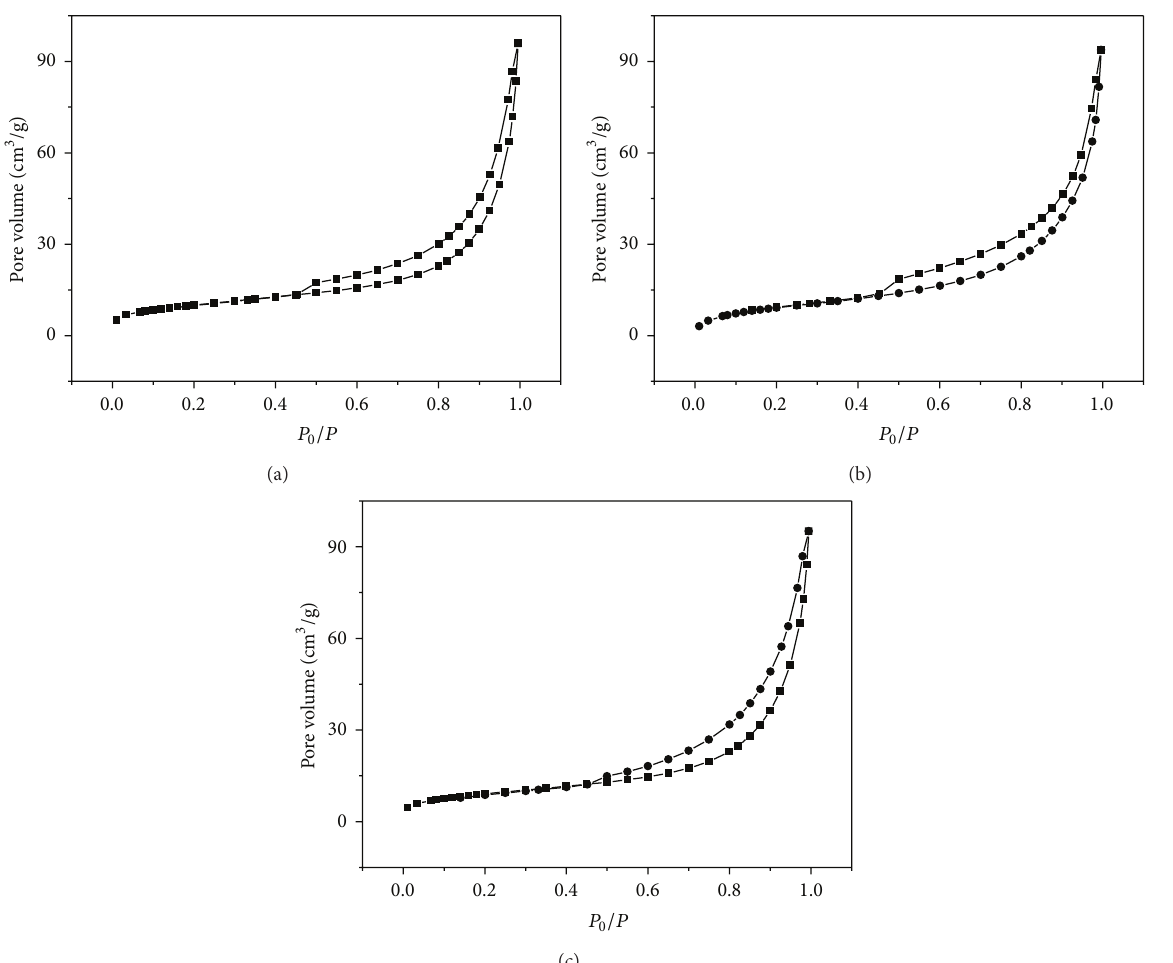
small amount of Cl element. The ratio of In to Cd in the microspheres is 1.95 which is very close to the atom ratio in CdIn 2 S 4 . The small amount Cl element is from the precursor of InCl 3 (H 2 O) 4 which is not completely removed during the washing of